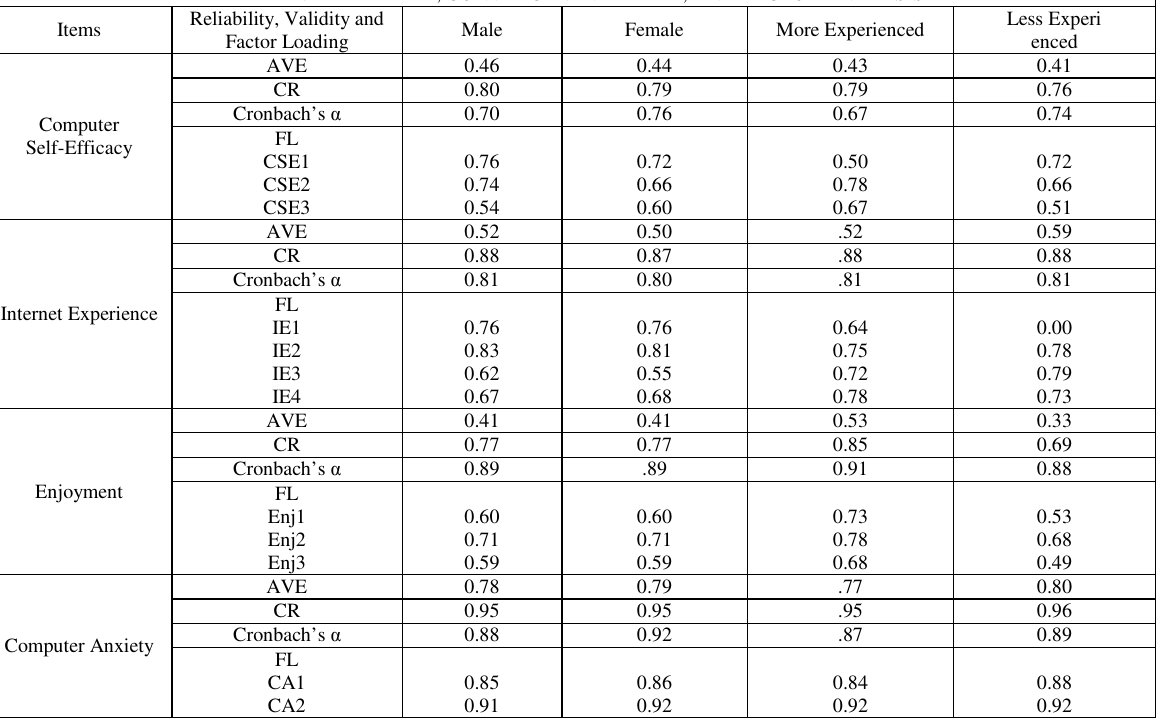
TABLE 2. RELIABILITY, CONVERGENT VALIDITY, AND FACTOR